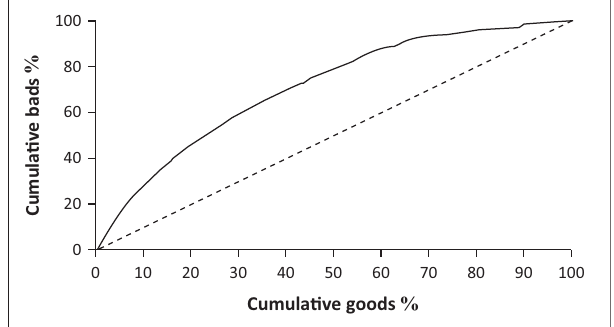
FIGURE 10: Empirica score Gini-coefficient (development